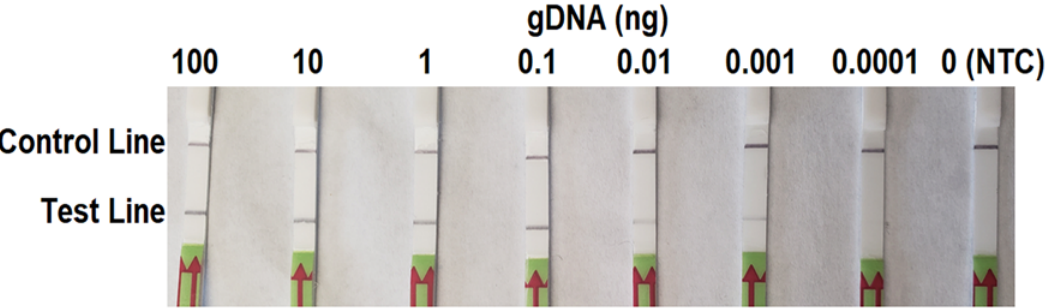
Figure 4. Evaluation results of sensitivity of the recombinase polymerase amplification ‐ lateral flow dipstick assay targeting the PHYCI_587572 biomarker using a 10 ‐ fold serial dilutions of genomic DNA (gDNA) of Phytophthora cinnamomi isolate Pci1. Nuclease ‐ free water was used in place of DNA